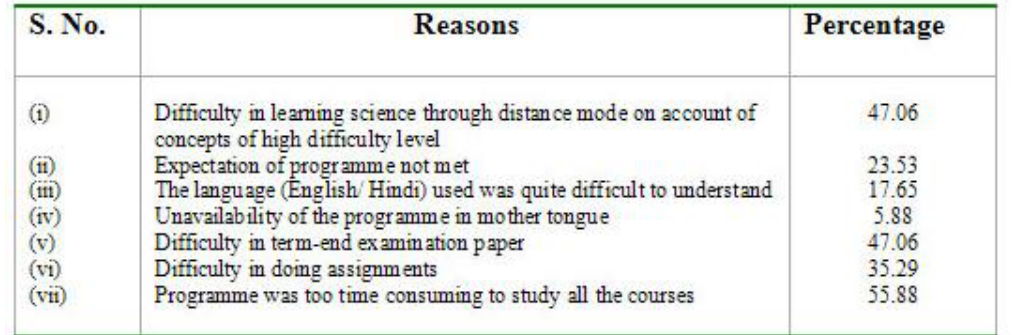
Table 3. Programme/ Course related reasons as response for withdrawal (expressed as a percentage of total number of